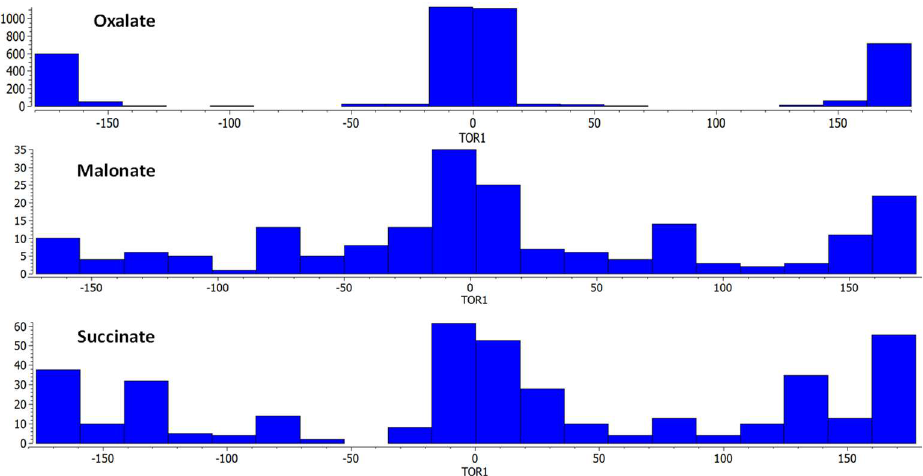
Figure 3. Torsion angle values for the entries in the CCDC for oxalate, malonate and succinate ligands.